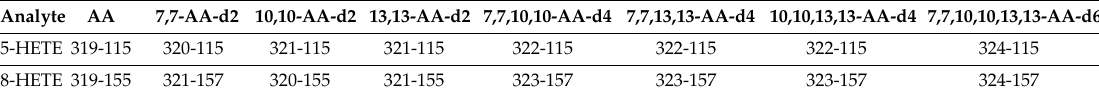
Table 3. Multiple reaction montitoring (MRM) transitions for 5-HETE and 8-HETE derived from deuterated arachidonic